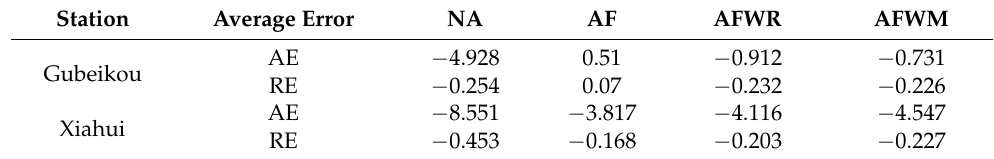
Figure 9. Variation in the flood runoff of large floods for the measurement and four assimilation settings for two stations: ( a ) Gubeikou; ( b ) Xiahui. Table 5. Average error values of the four assimilation settings for the two stations.